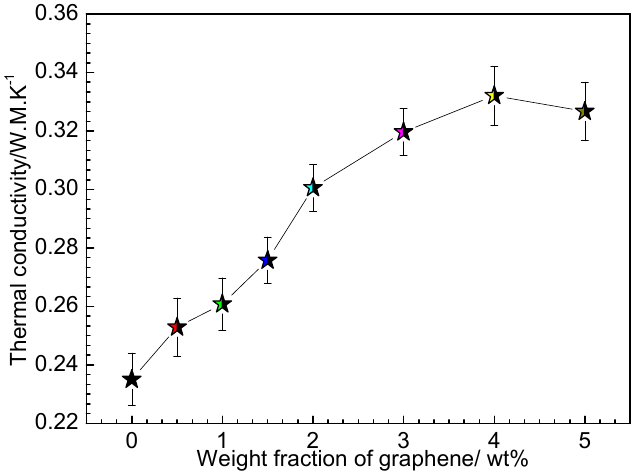
Figure 6. Thermal conductivity of G-TPU composite films with different mass contents of graphene.